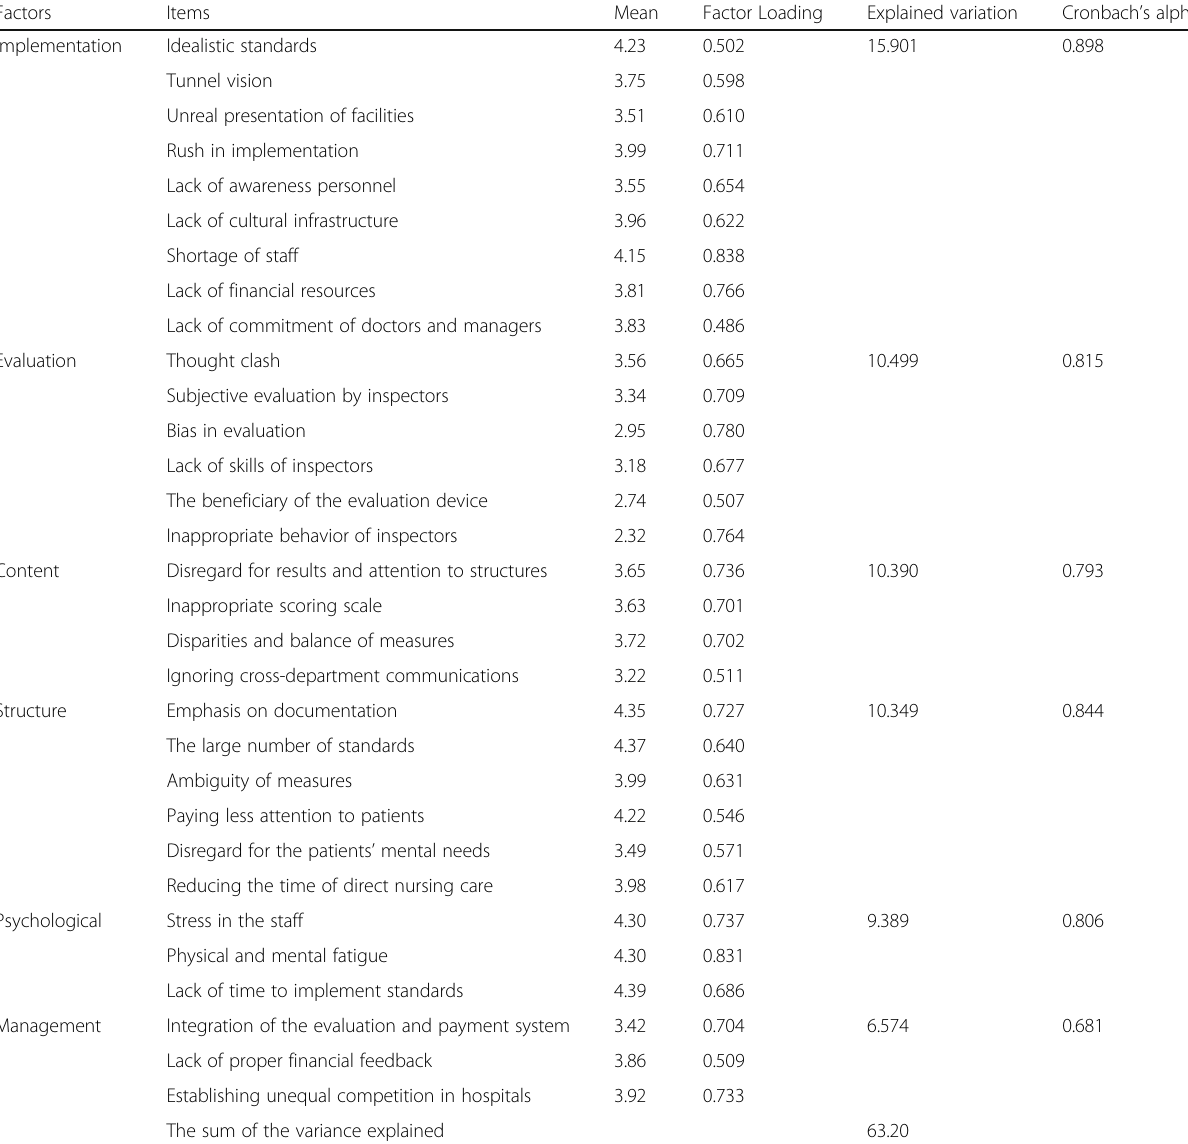
Table 4 Statistics on extracted factors and related variables